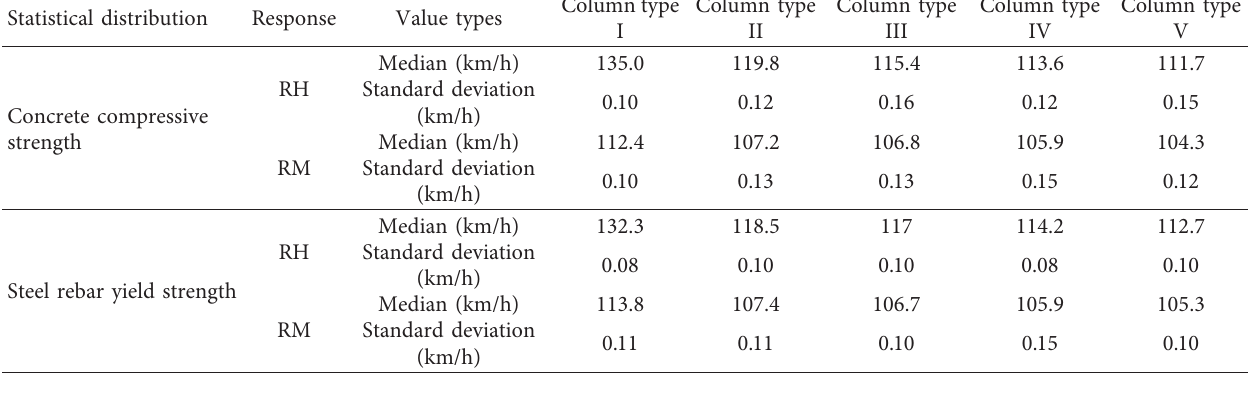
Table 7: Median values and standard deviation values depending on column